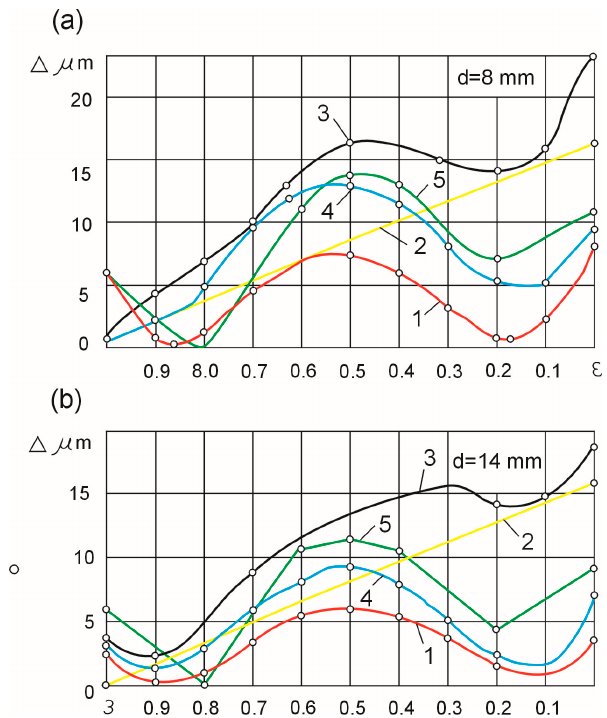
Figure 5. Shaft cylindricity errors when regulating the compliance of the investigated technological system (horizontal axis ε = x/L): ( a ) for d = 8 mm, ( b ) for d = 14 mm.